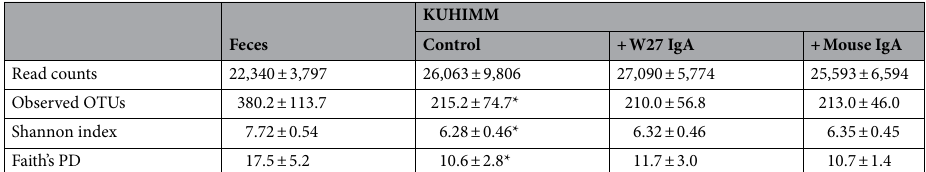
Table 1. Summary of 16S rRNA gene sequencing data and α-diversity values [Shannon index and Faith’s phylogenetic diversity (PD)]. In addition to twelve human fecal samples (Feces), the corresponding cultures without IgA (Control), the corresponding cultures with W27 IgA (+ W27 IgA), and the corresponding cultures with mouse monoclonal IgA (+ Mouse IgA) were sampled after 48 h of fermentation. The values are represented as mean ± standard deviation. Asterisks (*) represent significant differences (* p < 0.05) (n = 12) between the microbiota in the original feces and in corresponding cultures without IgA using Wilcoxon signed rank test. Significant differences were not detected between KUHIMMs without and with